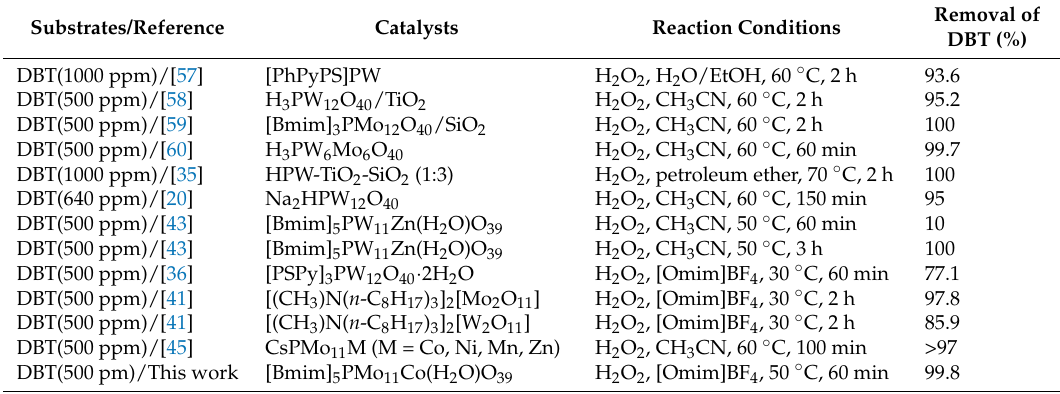
Table 2. Comparison with some related catalysis systems for the removal of